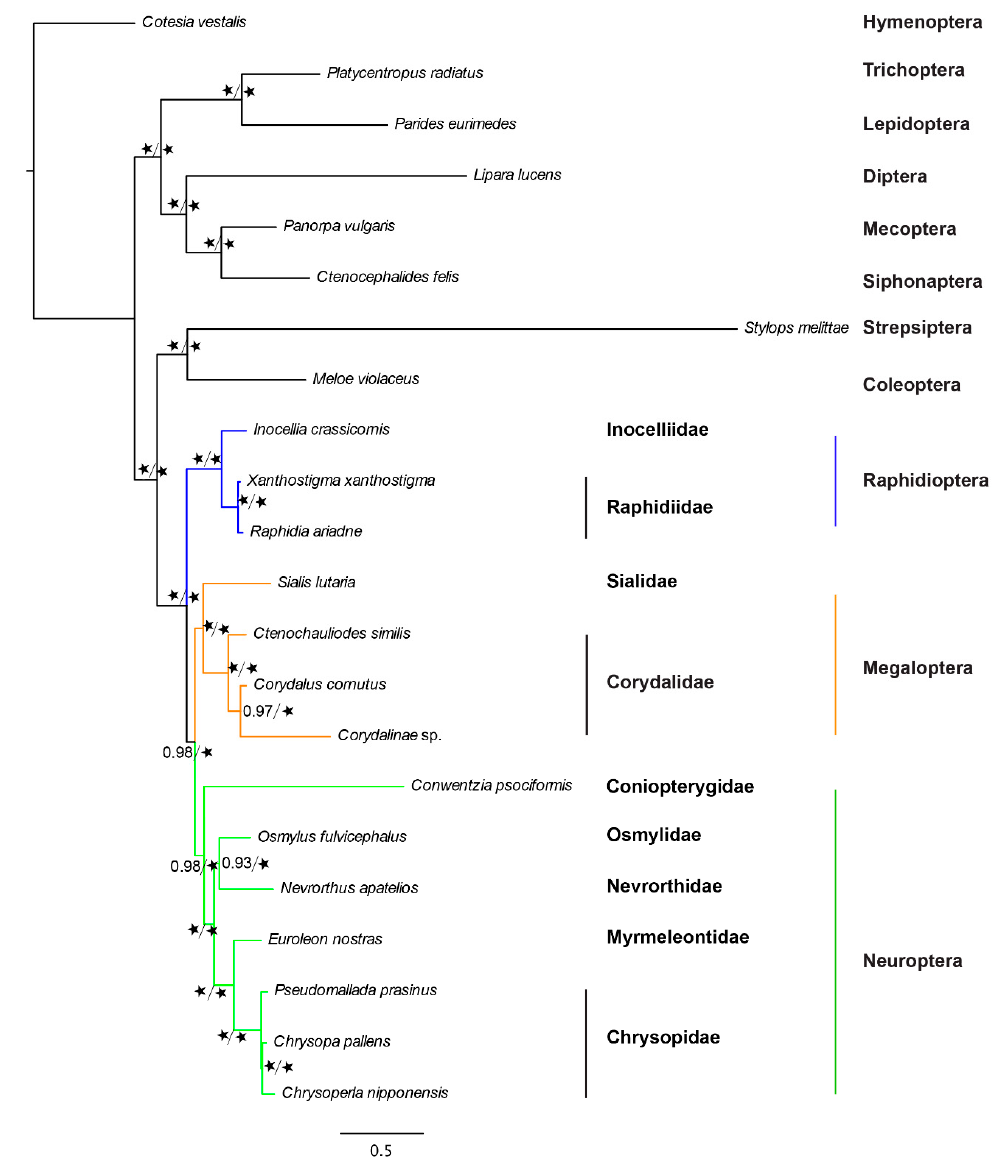
Figure 6. Phylogenetic reconstructions of Neuropterida based on amino acid sequences under site- heterogenous models. The data included all 1392 orthologous genes. The same topology was recovered by both Bayesian analysis under the CAT-Poisson model in Phylobayes and maximum-likelihood analysis under the LG+C60+F model in the IQ-TREE phylogenetic inference software. The two support values shown for each branch are Phylobayes posterior probability (left) and IQ-TREE ultrafast bootstrap support (right). The black asterisk indicates maximum support values.